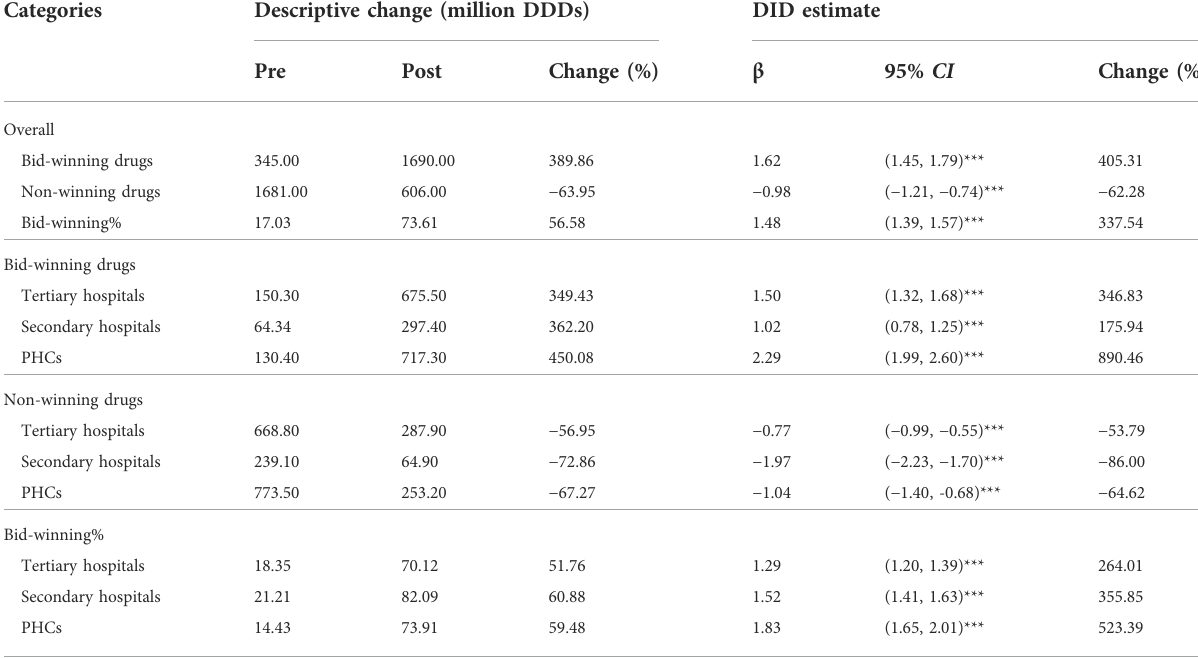
TABLE 1 Impact of the “ 4 + 7 ” pilot on monthly volumes of bid-winning or non-winning drugs, strati fi ed by healthcare